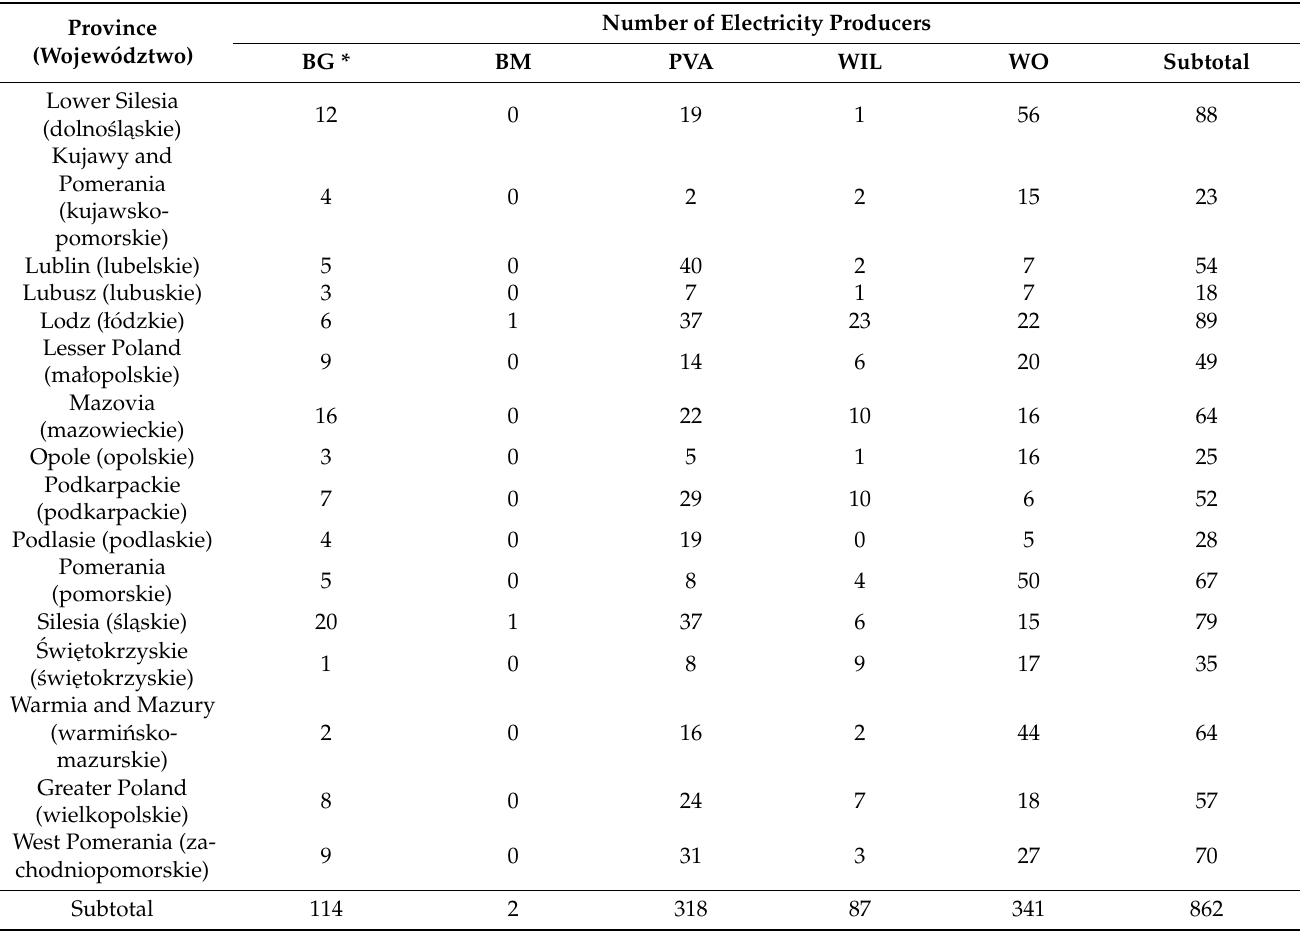
Table 8. Number of small installation electricity producers in Poland, divided by renewable energy sources as of 31 December 2020 (letter code in accordance with Table